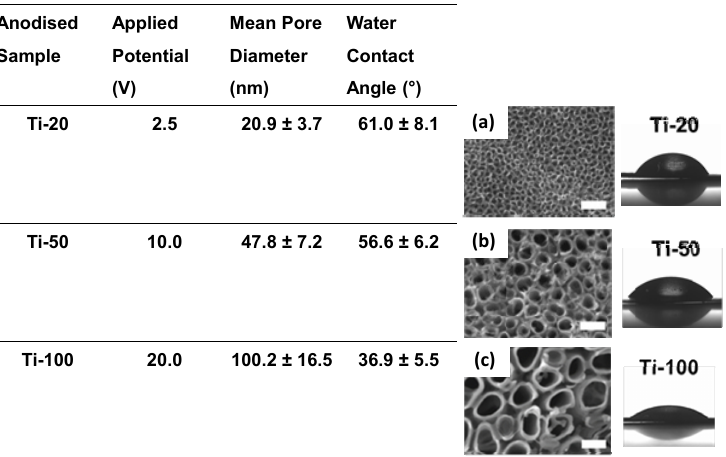
Figure 1. The applied voltage used for anodising pure titanium discs and the respective nanotube pore diameter and water contact angle with ( a )–( c ) top view FE-SEM micrographs of the anodised samples and their respective water contact angle diagrams. Scale bar = 100 nm.